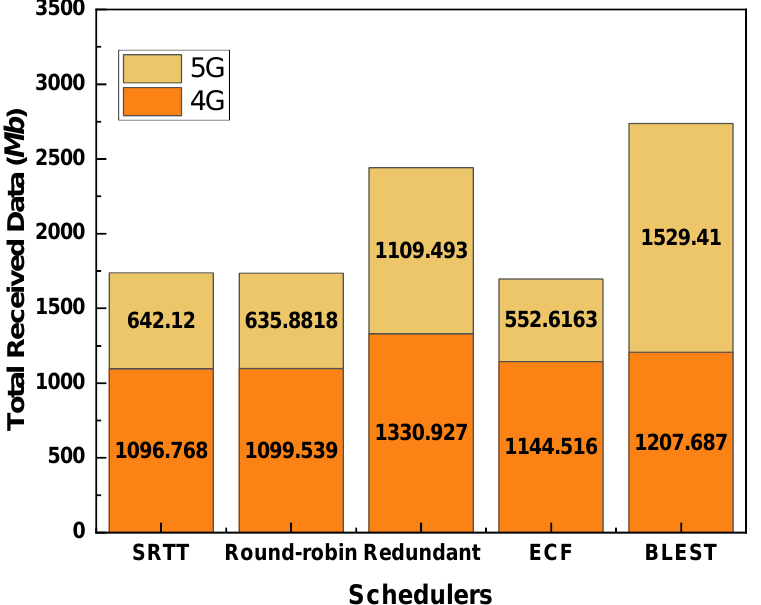
Figure 6. Performance of the tested MPTCP schedulers in terms of total received data for OLIA as a CCA.